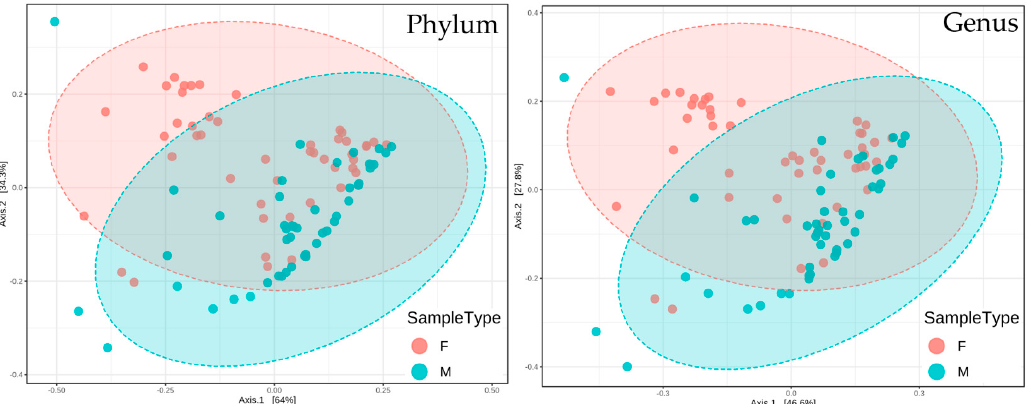
Figure 4. Graphic representation of β -diversity at the phylum and genus taxonomic levels.